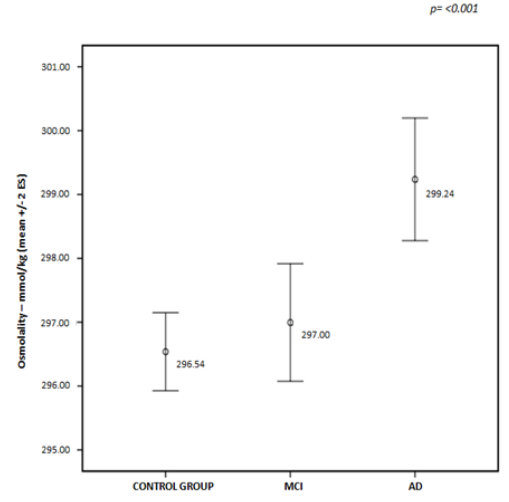
Figure 1. Distribution of osmolality mean values in control group, and mild cognitive impairment (MCI) and Alzheimer’s disease (AD) patients.